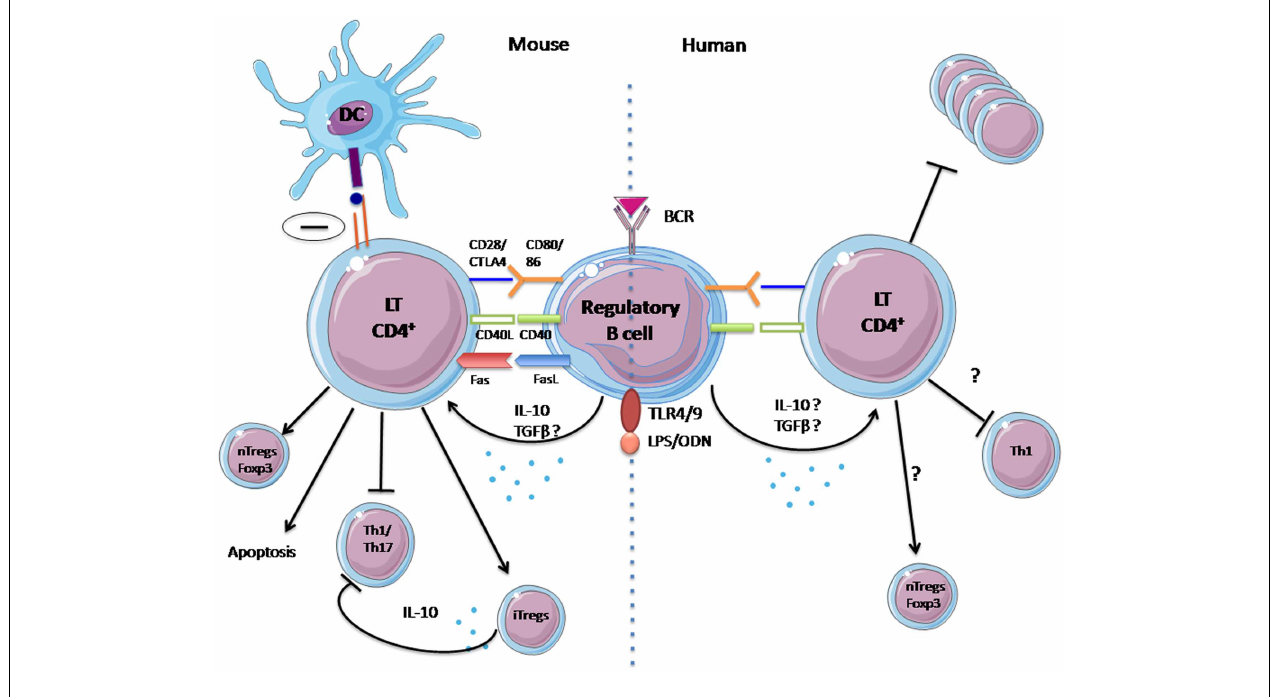
and (3) induction of natural regulatoryT cells. For humans, the mechanisms for the actions of regulatory B cells remain unclear and have yet to be confirm: (1) Probable inhibition of proliferation of CD4 + T cells, (2) Possible inhibition ofTh1 differentiation, and (3) possible increase of natural regulatoryT